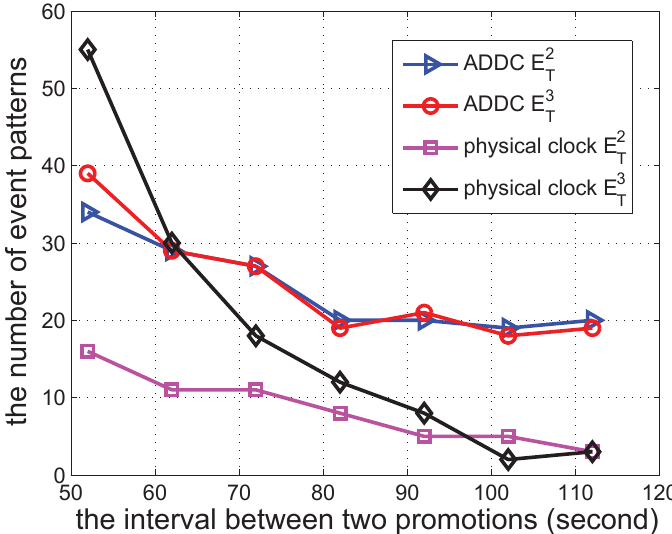
Figure 9. The number of event patterns vs. the interval between two